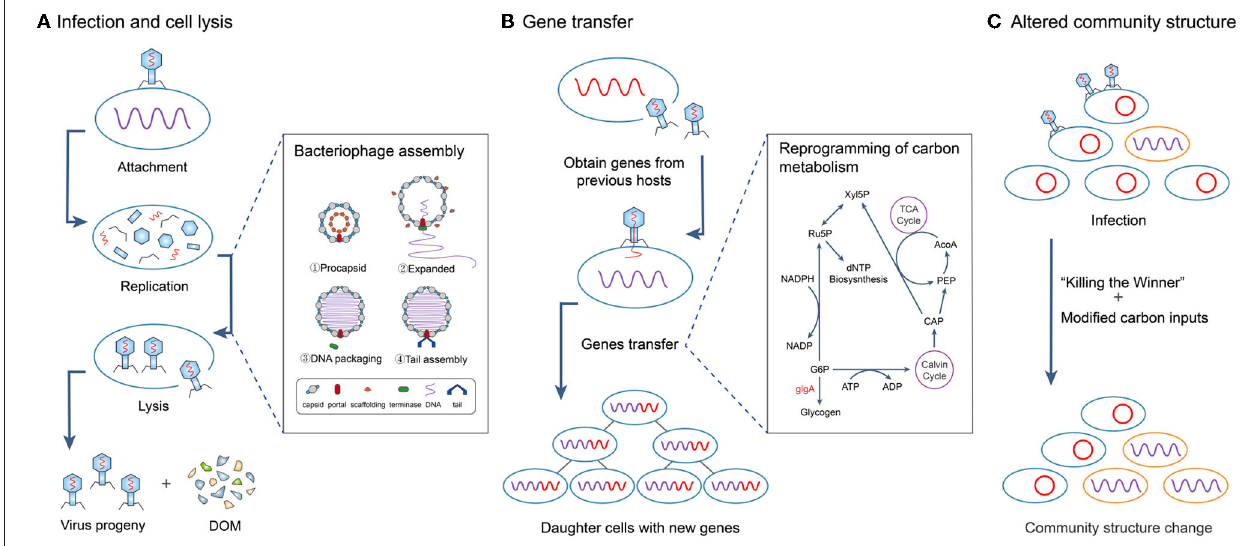
FIGURE 2 | Three major mechanisms by which viruses affect microbial community structures and regulate carbon cycling. (A) Viruses infect microbial hosts and invade and destroy microbial cells (lysis) leading to the direct release of carbon in dissolved organic matter (DOM). (B) After virus infection, gene transfer from the virus (and/or previous host) previous host reprograms carbon metabolism. (C) Virus infection changes the magnitude of carbon inputs and changes microbial community structure, e.g., “Killing the Winner” mechanism.